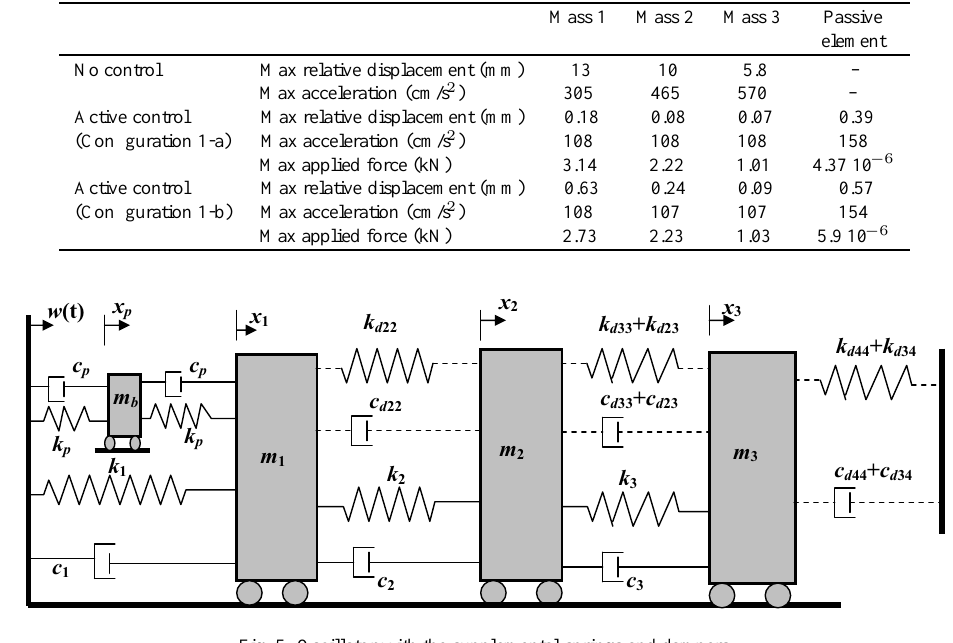
Fig. 5. Oscillator with the supplemental springs and dampers.